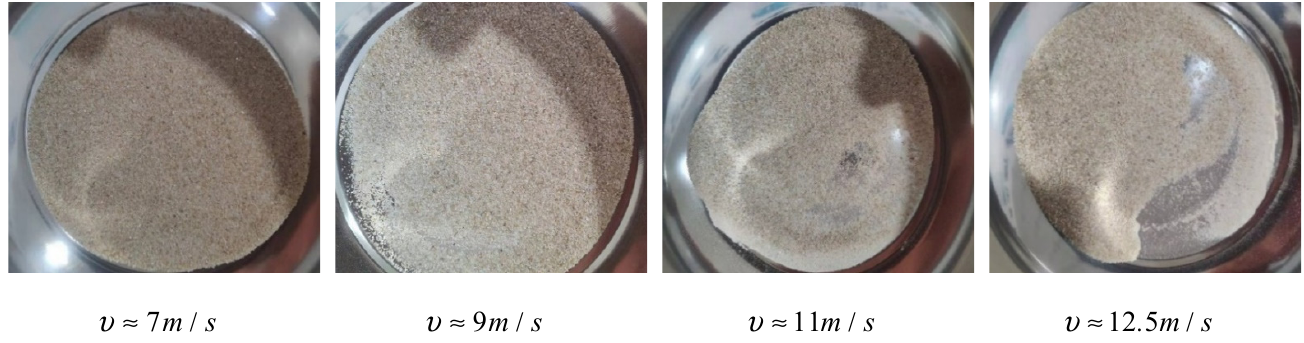
Figure 12. Failure phenomena of the dry sand specimens with initial relative density of 0.9 after impact loading.